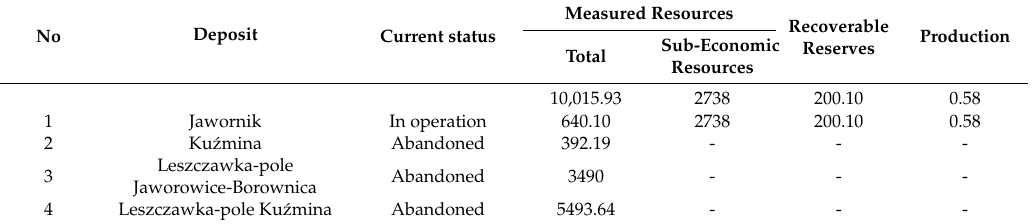
Table 3. List of diatomaceous earth deposits in Poland (thousand t)